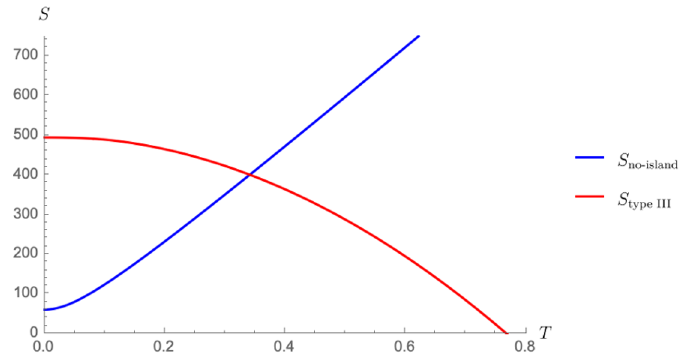
Figure 7 . The Page curve for the universal cover of a 2d Schwarzschild-de Sitter black hole in universe B . The blue curve is the thermal entropy of CFT fields on A , and the red curve is the entropy of a type III